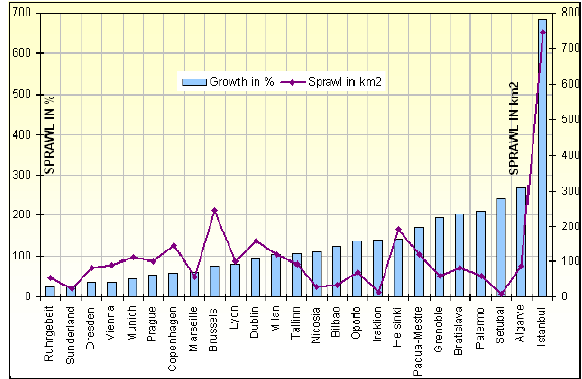
Figure 10: urban sprawl of “MOLAND”-Cities within the last 50 years.